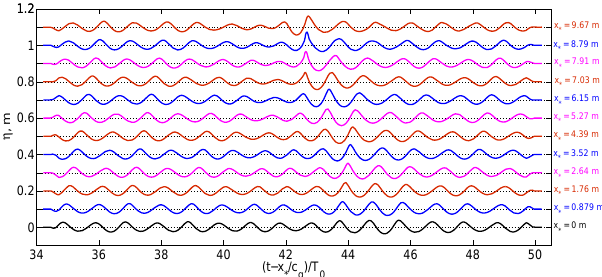
Figure 5. The computed temporal variation of the surface elevation at various locations relative to the wavemaker in a moving (with c g ) reference frame.